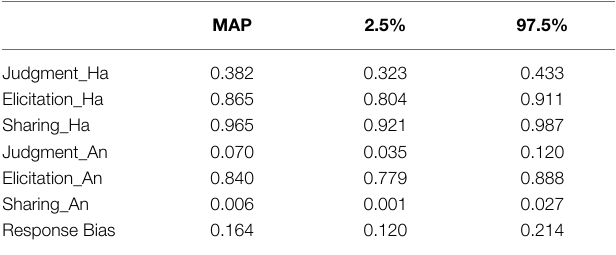
TABLE 3 | All parameters in Model